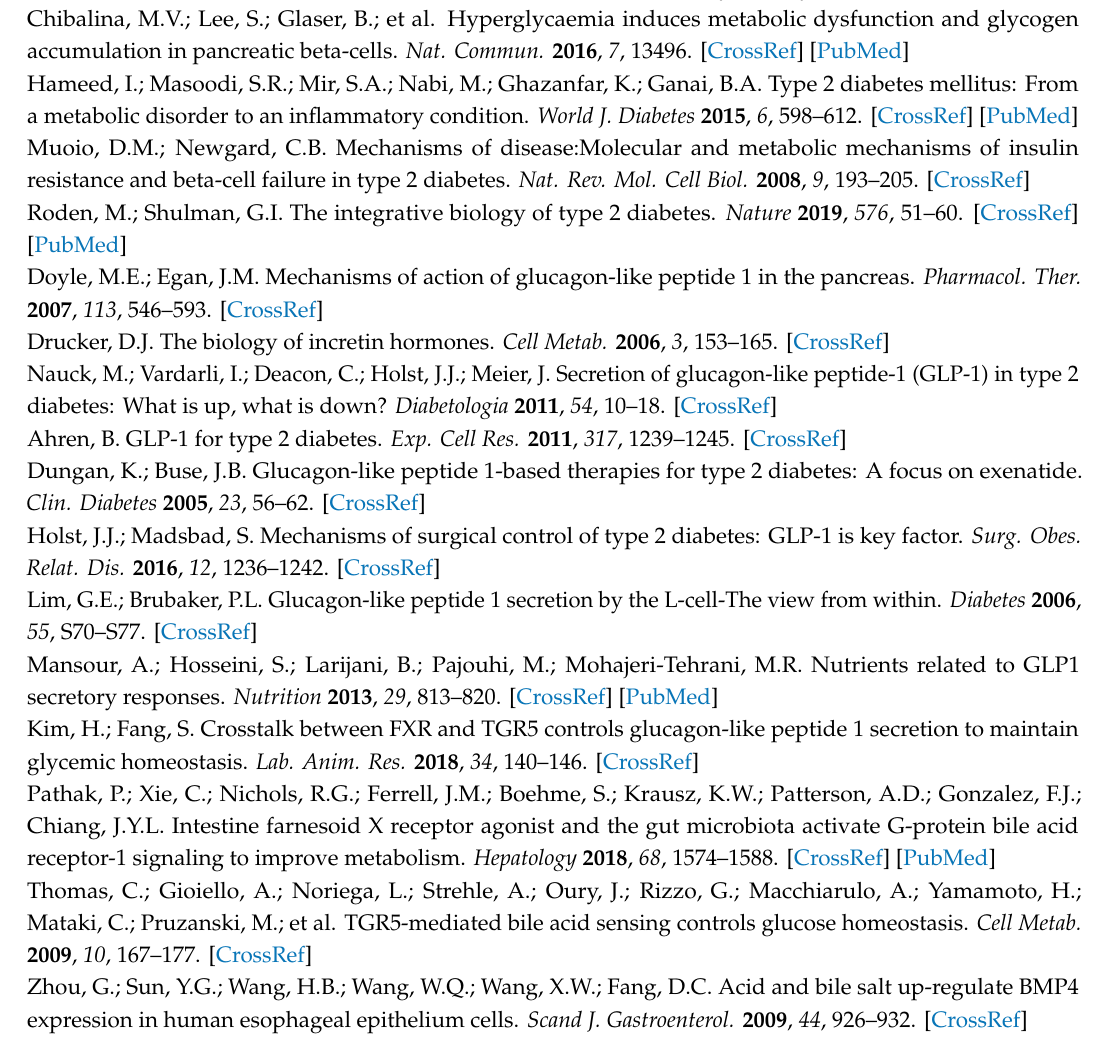
Figure S1: Count of overlapped genes in normal versus starvation and starvation versus replenishment DEGs. Figure S2: ID4 protein level according to nutrient status. Figure S3: ID4-mediated BMP signaling modulates GLP-1 secretion in GLUTag